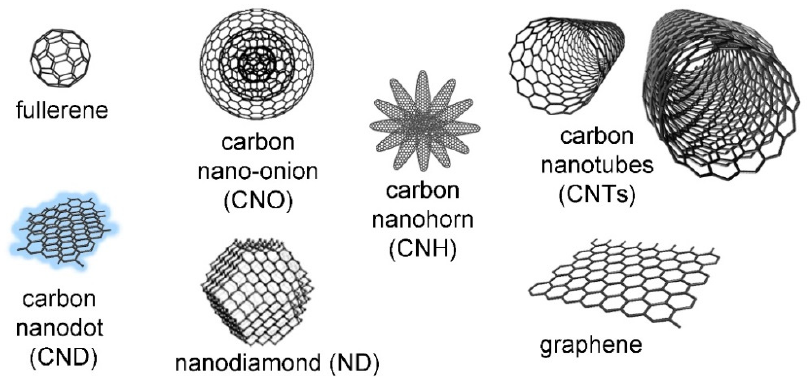
Figure 2. Carbon nanomaterials (not to scale), reproduced from [25]. The nano-onion is reproduced from [26]; copyright © 2022 with permission from Elsevier.